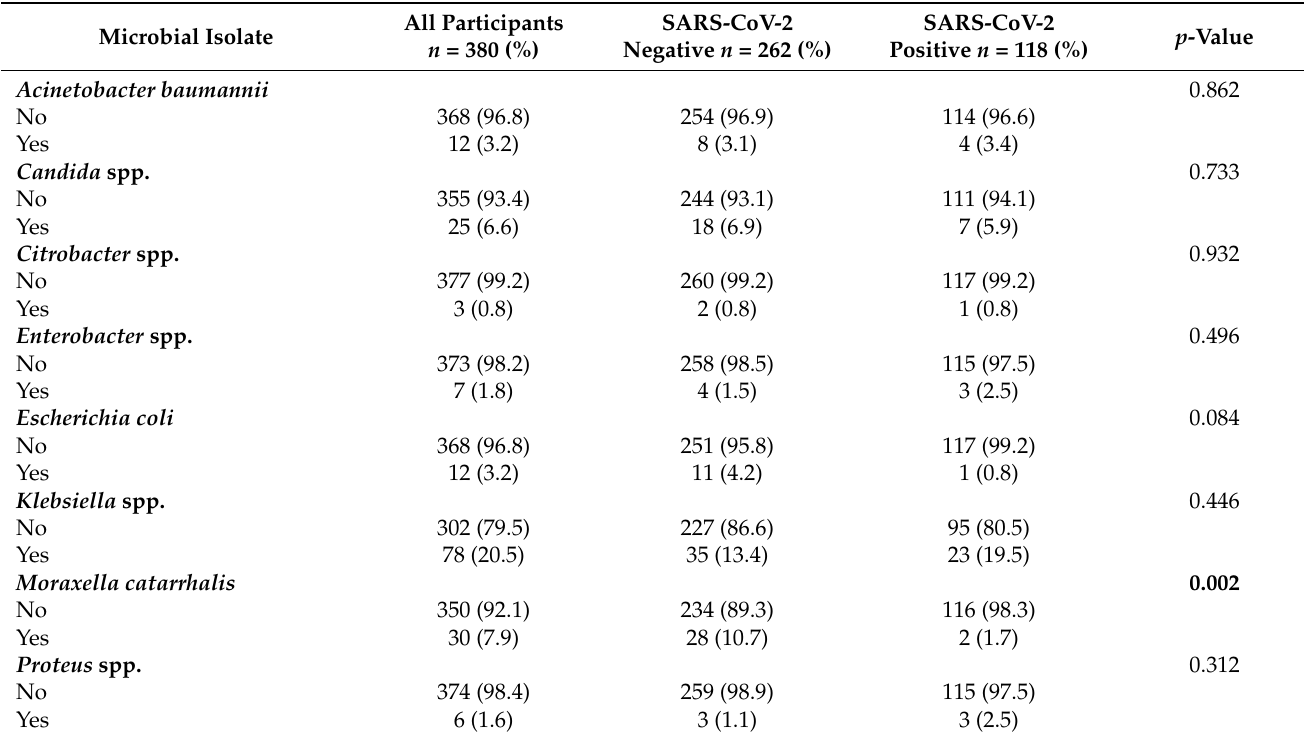
Table 3. Microbial isolates among study